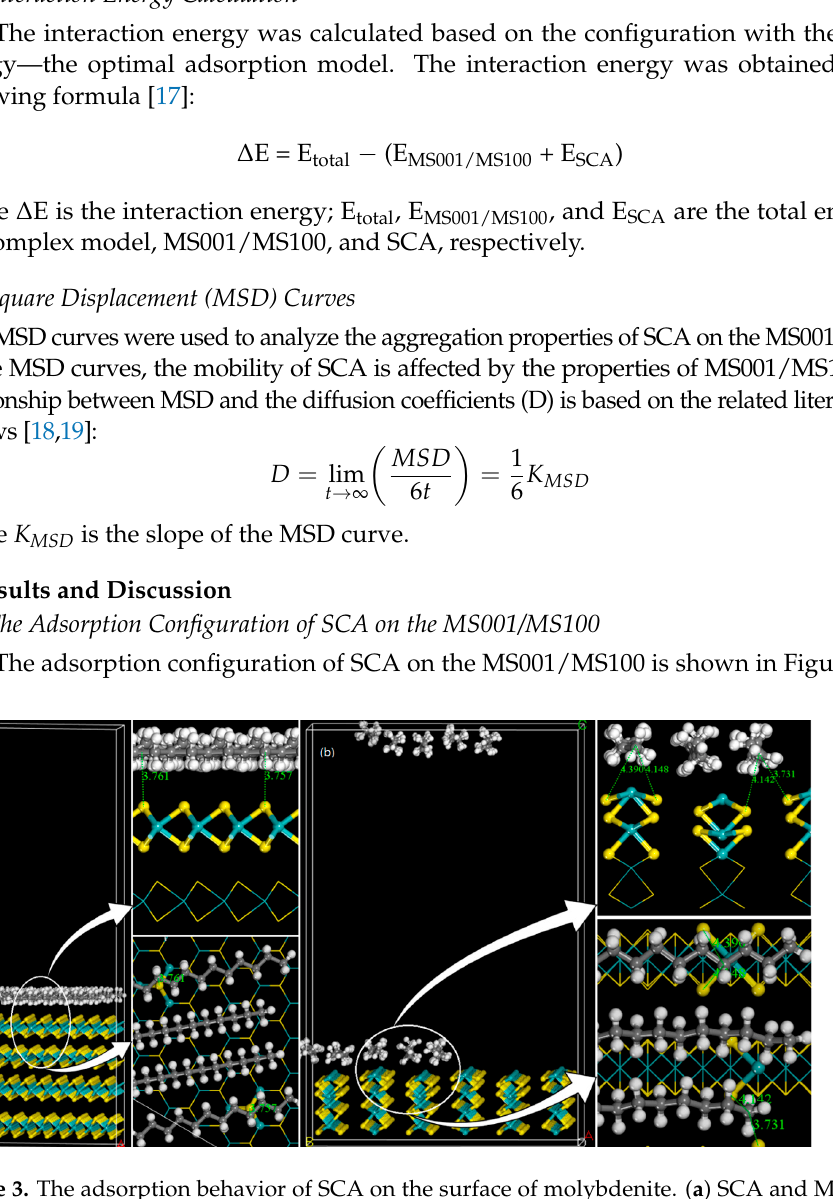
Figure 2. The optimization of the MS001/MS100–SCA compound model. ( a ) SCA and MS001; ( b ) SCA and MS100.